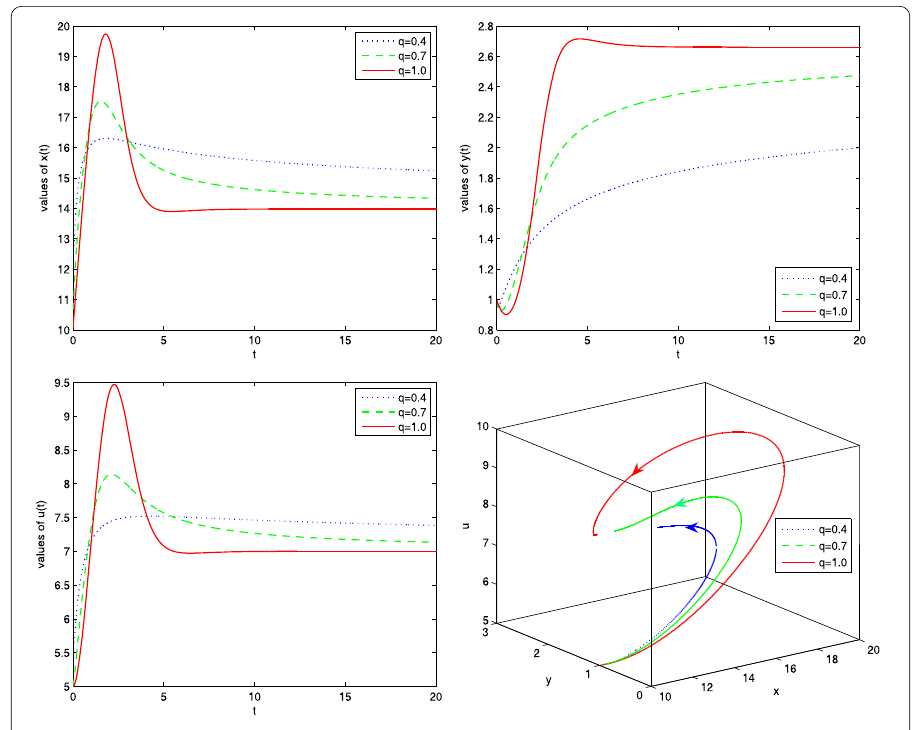
Figure 5 Impact of fractional order q on system (3) with ( x 0 , y 0 , u 0 ) =